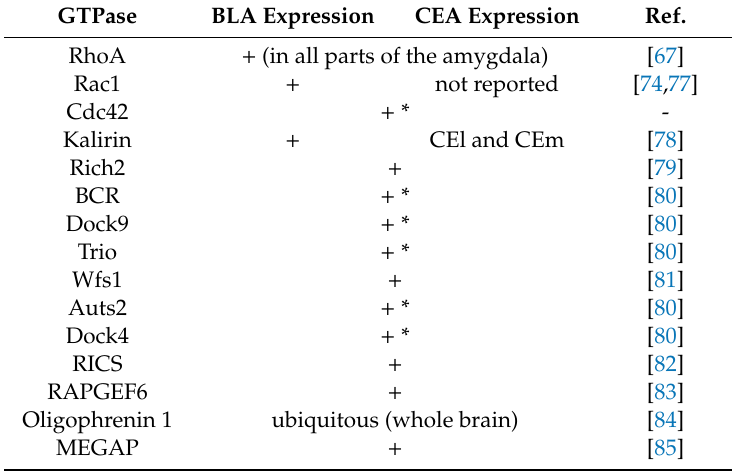
Table 2. Expression of Rho GTPases and their modulators in amygdala subregions in rodents. GTPase BLA